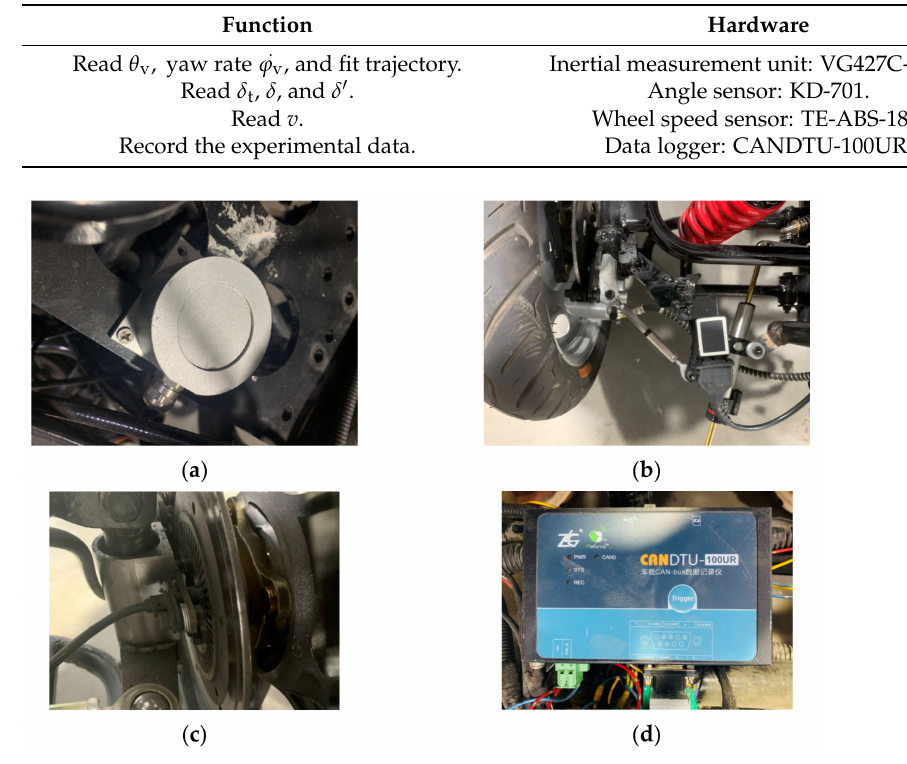
Figure 9. The equipment of the experiment. ( a ) Inertial measurement unit; ( b ) angle sensor; ( c ) wheel speed sensor; ( d ) data